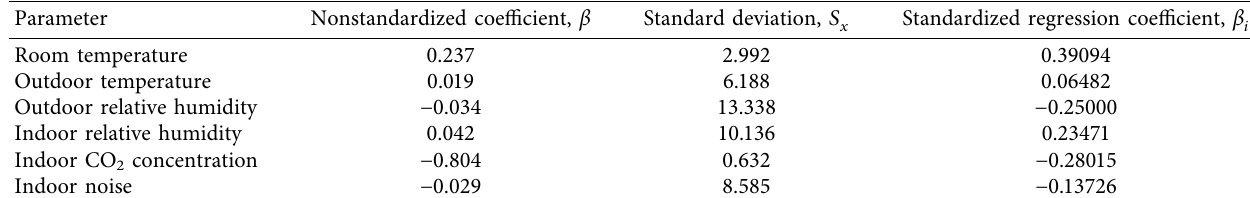
Table 9: Standardized regression coefficients for the control